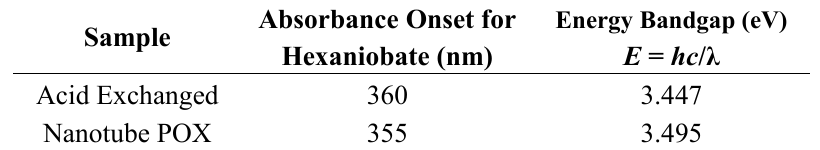
Table 2. Onset of absorbance and energy band gap for hexaniobate metal